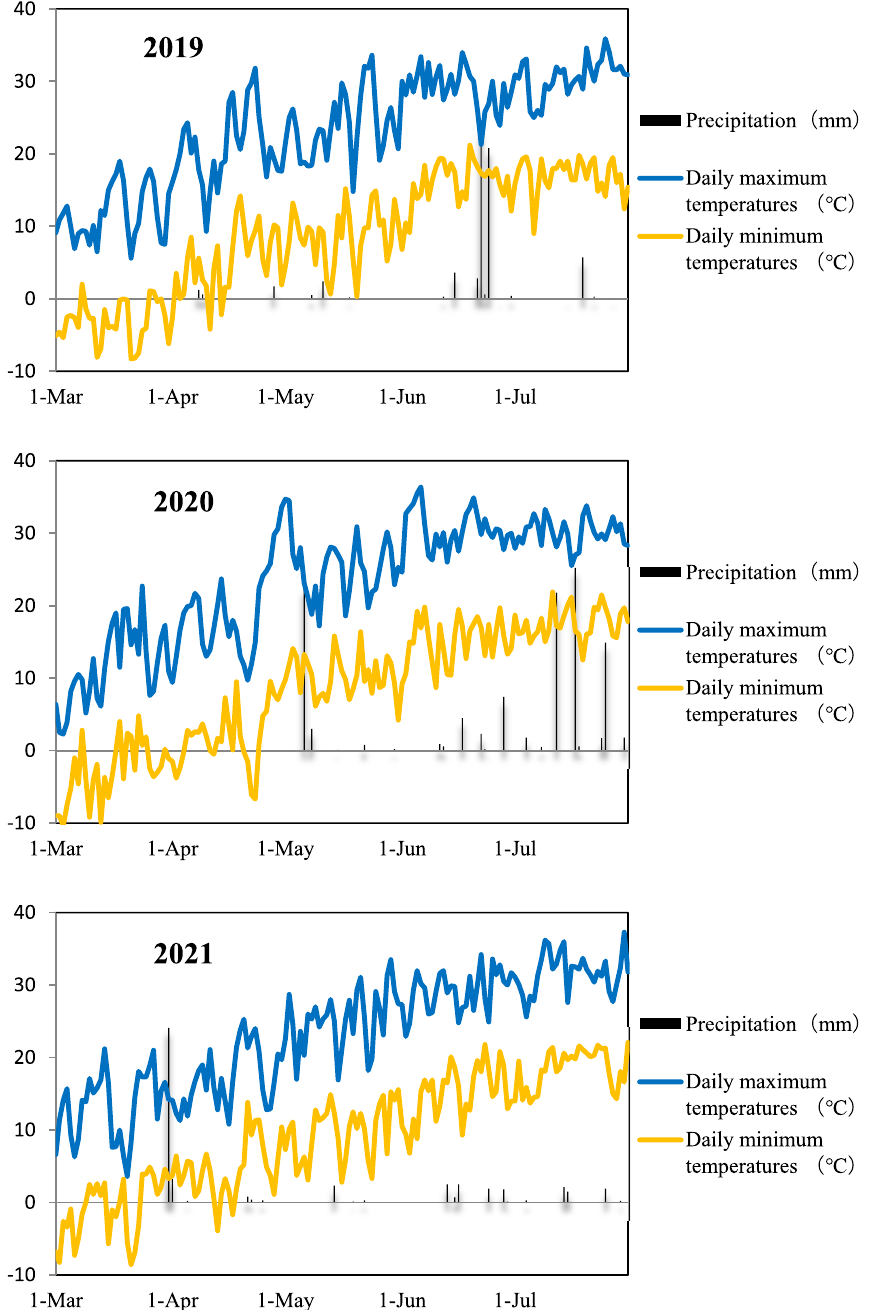
Figure 1. Daily maximum temperature, daily minimum temperature and precipitation during the growth period (March–July) of spring wheat from 2019 to 2021 in the field experiment at Linhe, Inner Mongolia,